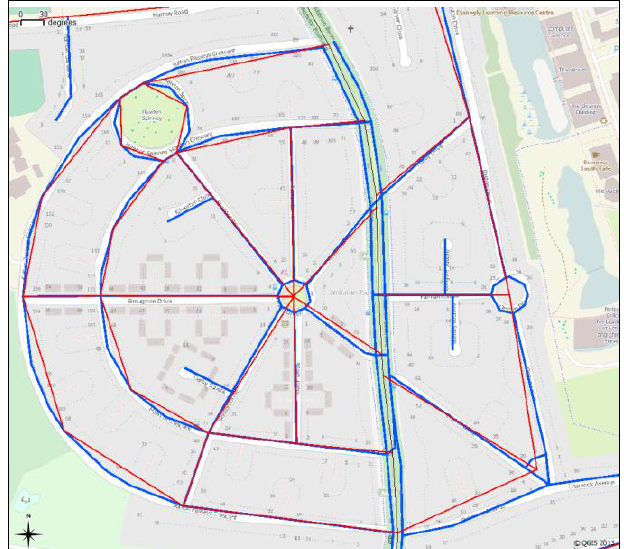
Figure 1. Comparing the roads in VectorMap District (VMD) (blue) and Meridian (red) on an OpenStreetMap (OSM) background. The two overlay maps are different in terms of completeness and accuracy.